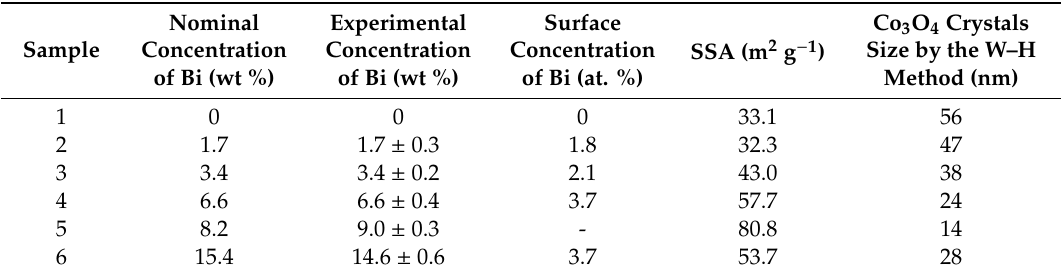
Figure 2. Rates of the catalytic N 2 O decomposition for the undoped Co 3 O 4 catalyst and the Co 3 O 4 catalysts doped with 1.7–15.4 wt % of Bi (the lines illustrate graphically the observed trends). Table 1. Characterization of the undoped and Bi-doped spinel-based catalysts: nominal and experimental (X-ray fluorescence spectroscopy (XRF)) concentrations of bismuth, surface concentration of bismuth (X-ray photoelectron spectroscopy (XPS)), values of specific surface area (SSA) and Co 3 O 4 crystals size determined by the Williamson–Hall (W–H) method, applied to the results of the X-ray diffraction (XRD) measurements.